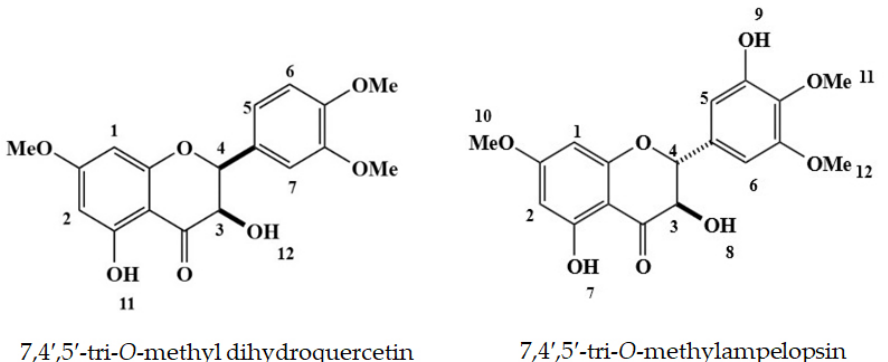
Figure 3. Chemical structures of compounds.